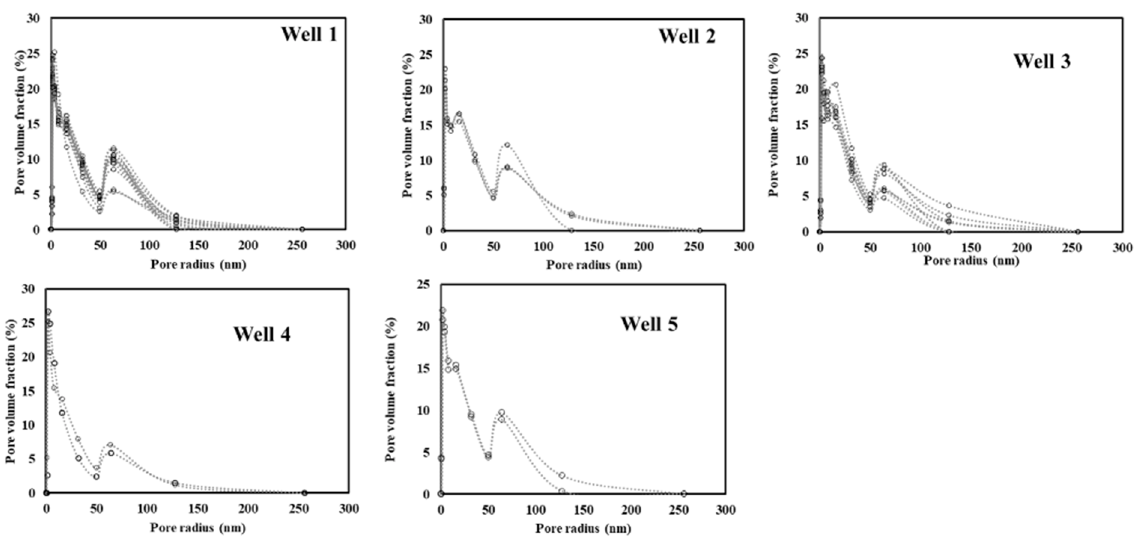
Figure 1. Pore size distributions in 5 wells in the Q formation using low-pressure nitrogen experiments.